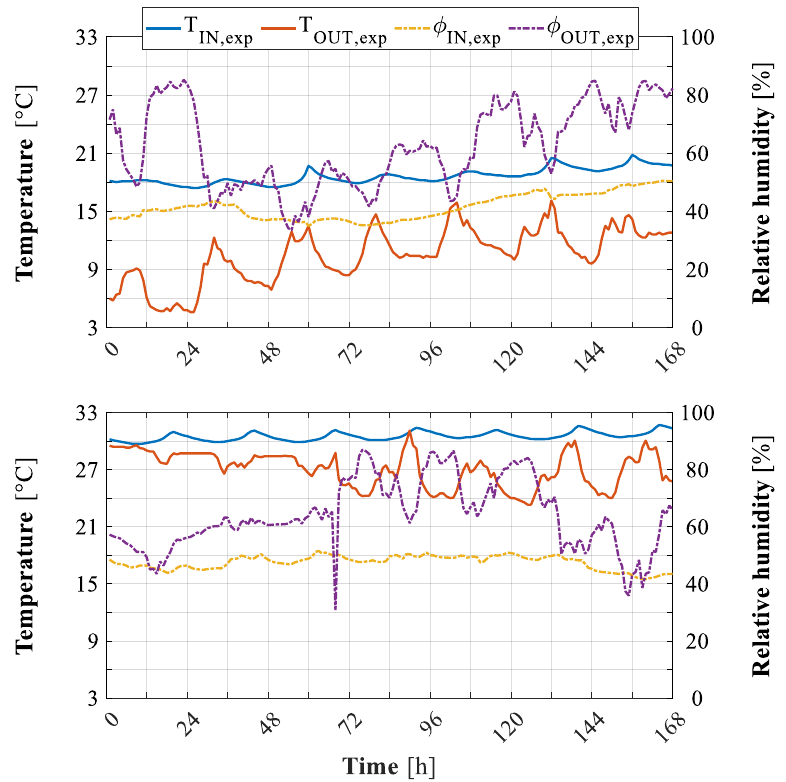
Figure 10. Time histories of indoor and outdoor air temperatures and relative humidity—Sample winter week: March 23rd – 29th ( top ) and sample summer one: July 1st – 7th ( bottom ).